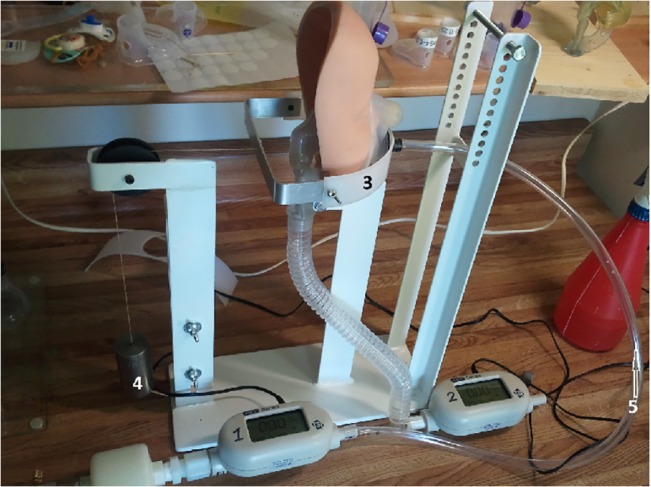
Test Assembly.(#1) Inflow meter represents the baseline ("complete seal") and reflects maximum available inspiratory flow. (#2) Outflow meter input port is connected through flexible tubing to the “trachea”. Its exit port is open to the atmosphere. The airflow measured at this flow meter represents the flow volume through the mask and the model. (#3) Belt holding the mask to the model with various forces (#4).